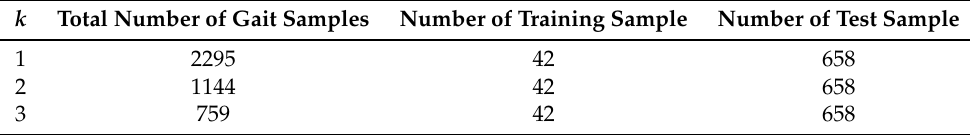
Table 1. The total number of gait data samples according to the value of k with the number of training and test